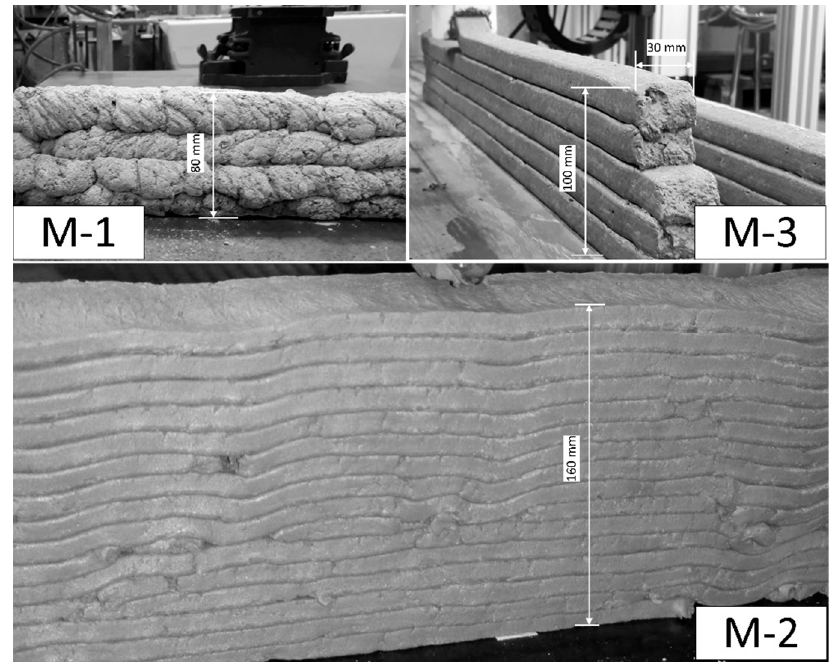
Figure 10. Extruded wall samples. M1 was extruded manually.